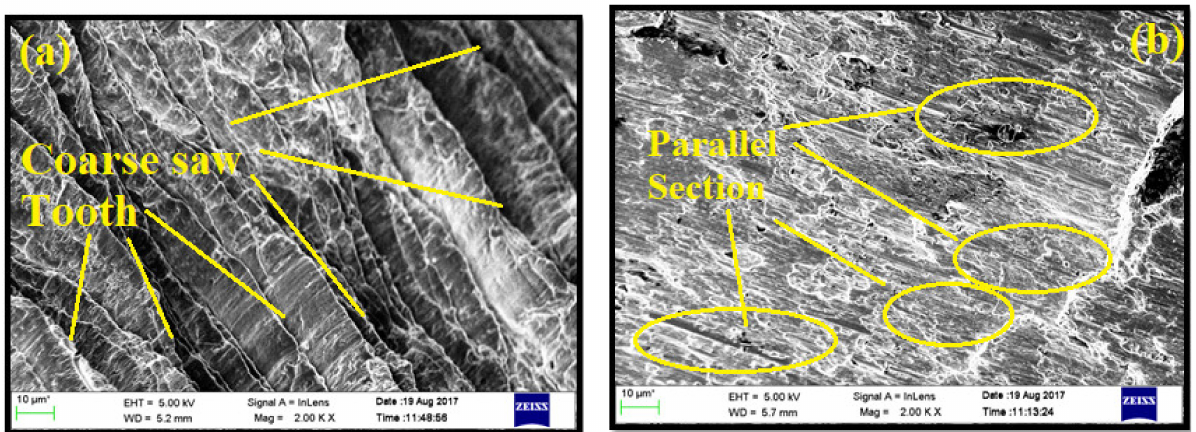
Figure 12. FESEM micrograph images of chip back surface in drilling: ( a ) AA7075, 3 wt.% TiB 2 AMCs at 1000 m/minute;